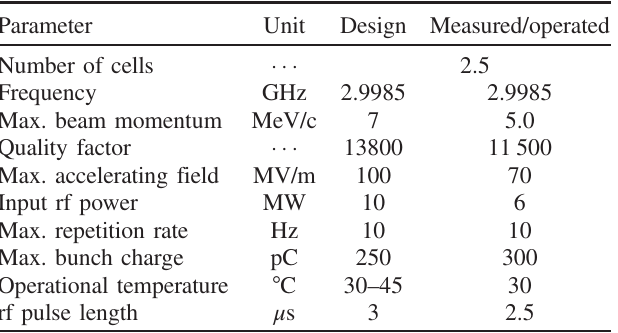
TABLE III. Design and operational parameters of the 10 Hz photoinjector.